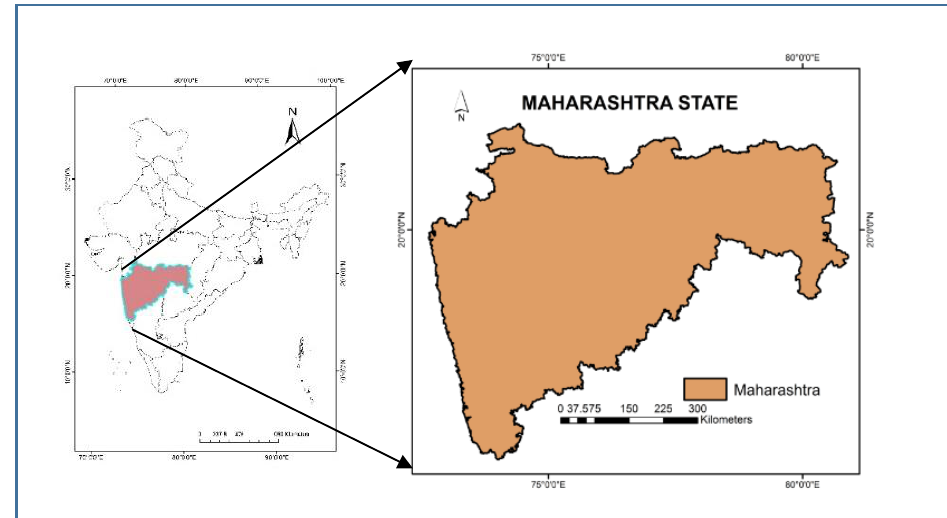
Figure 1. Study Area – Maharashtra